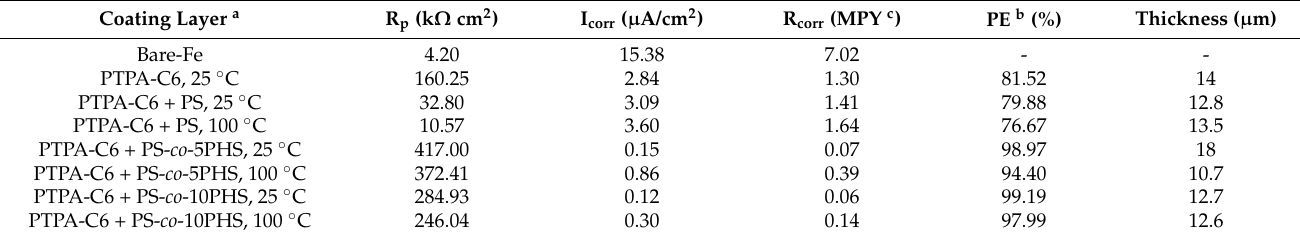
Figure 5. Tafel plots of ( a ) PTPA-C6 + PS- co -5PHS, and ( b ) PTPA-C6 + PS- co -10PHS at 25 ◦ C and 100 ◦ C. Table 2. Electrochemical properties of PTPA-C6, PTPA-C6/PS, PTPA-C6/PS- co -5PHS, and PTPA-C6/PS- co -10PHS blends coated on iron substrates for EIS measurement in 3.5% NaCl